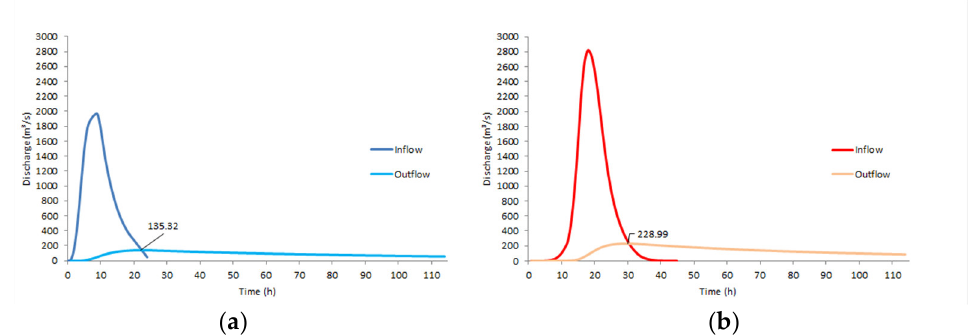
Figure 8. Flood transits based on the original design with PMP ( a ) without CC and ( b ) with CC.